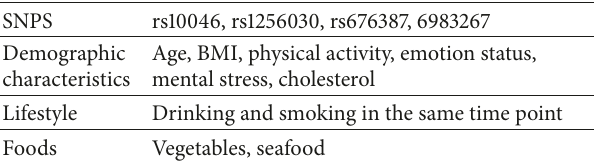
Table 6: Mutually explored